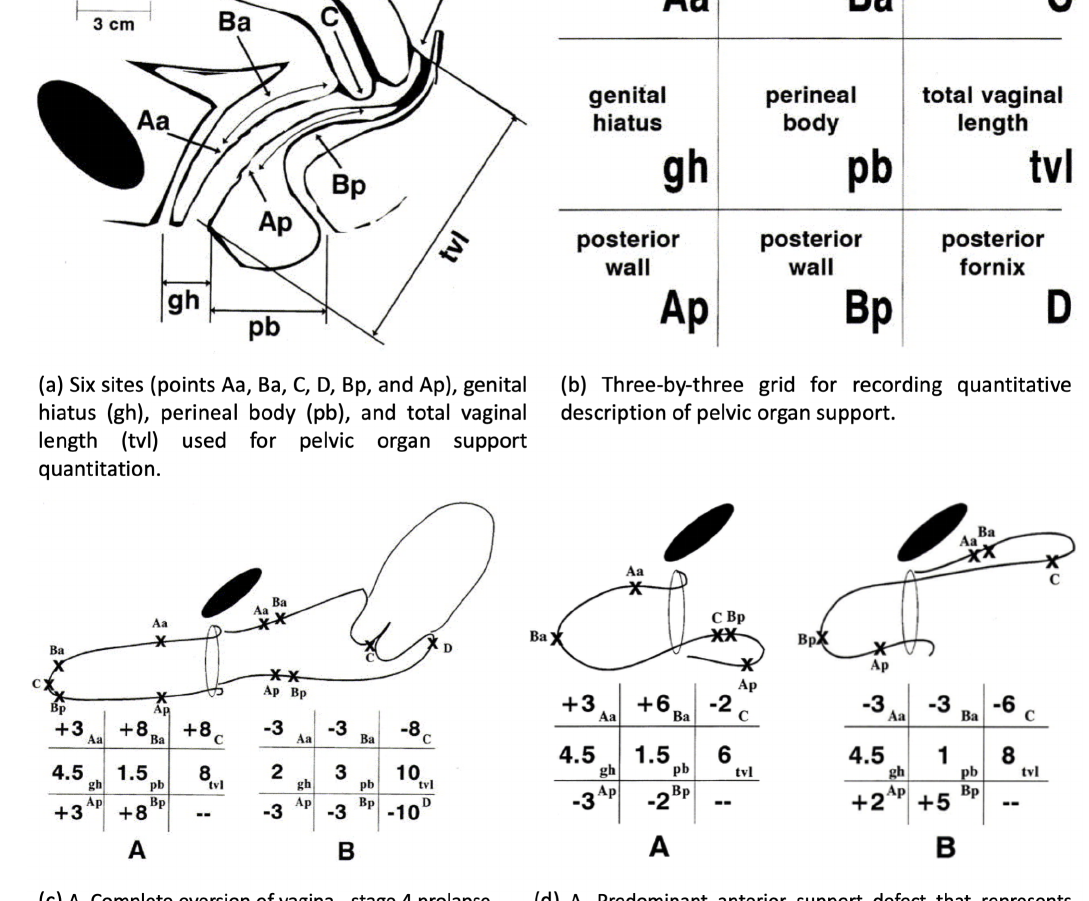
Figure 10. Standardization of terminology and four diagnostic examples. Reproduced from Bump